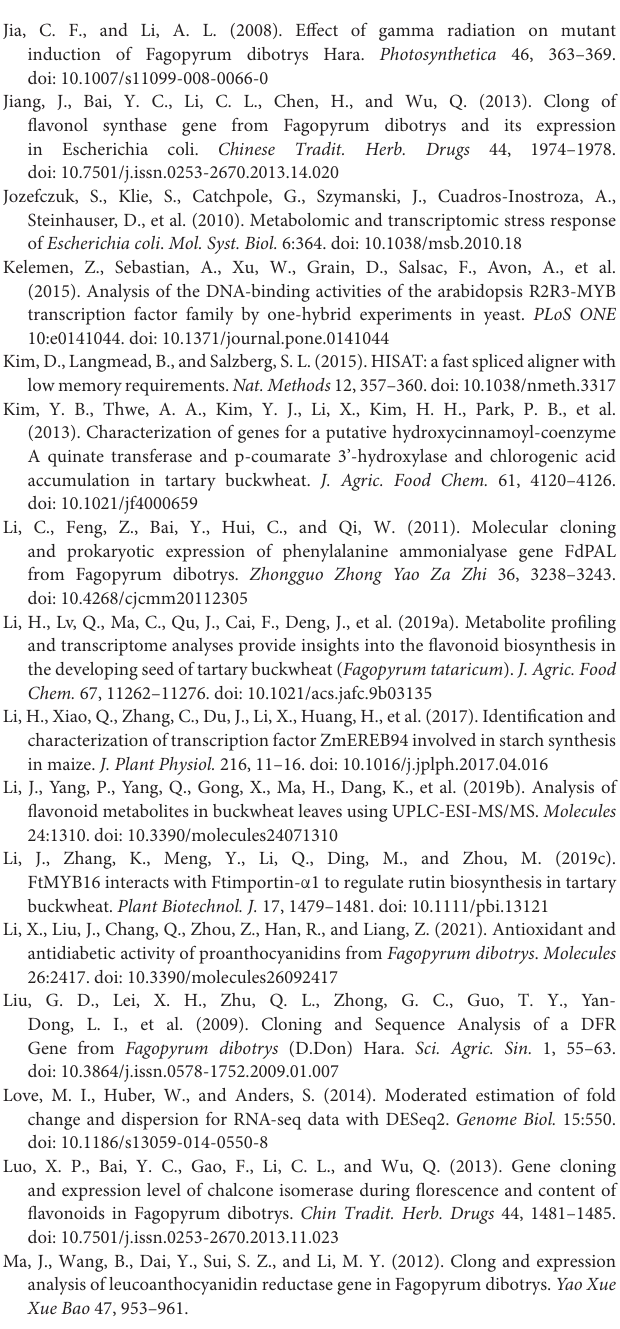
thresholds were set as the absolute value of log 2 ratio ≥ 1 and P -value (padj) < 0.05. Supplementary Table 4 | All metabolites identified in golden buckwheat